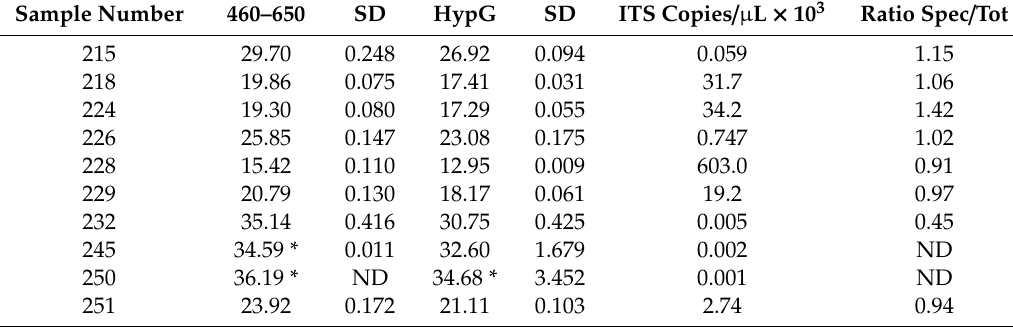
Table 4. Testing of commercial samples using the updated qPCR assay. The mean Cq and standard deviation (SD) were calculated from triplicate reactions using the HypG and 460–650 primers are shown. The number of ITS copies / µ L were calculated from the H. perforatum C22 reference standard curve. Cq values marked * indicate failure of one or more of the triplicate readings and a mean Cq value similar to the NTC control. The ratio of specific to total ITS copies was calculated directly using the formula of Pfa ffl